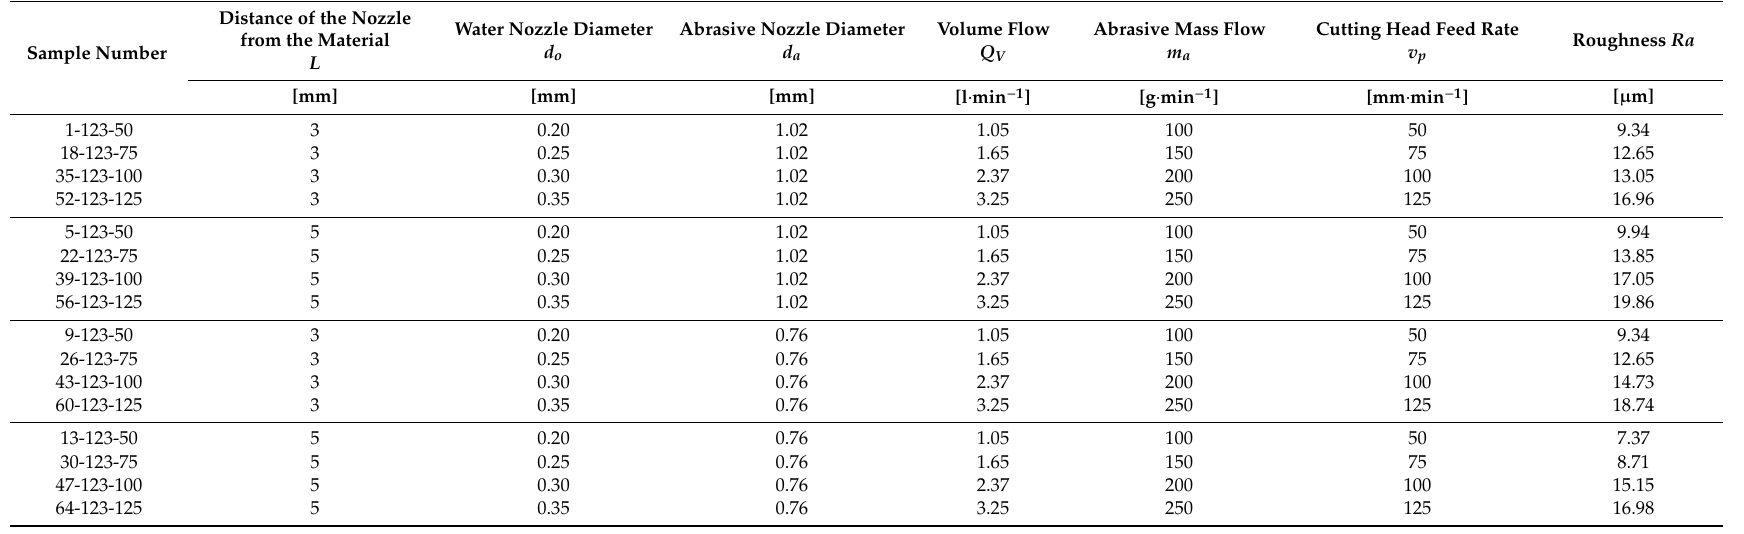
Table 6. The final collection of test sample cutting data [R / A /